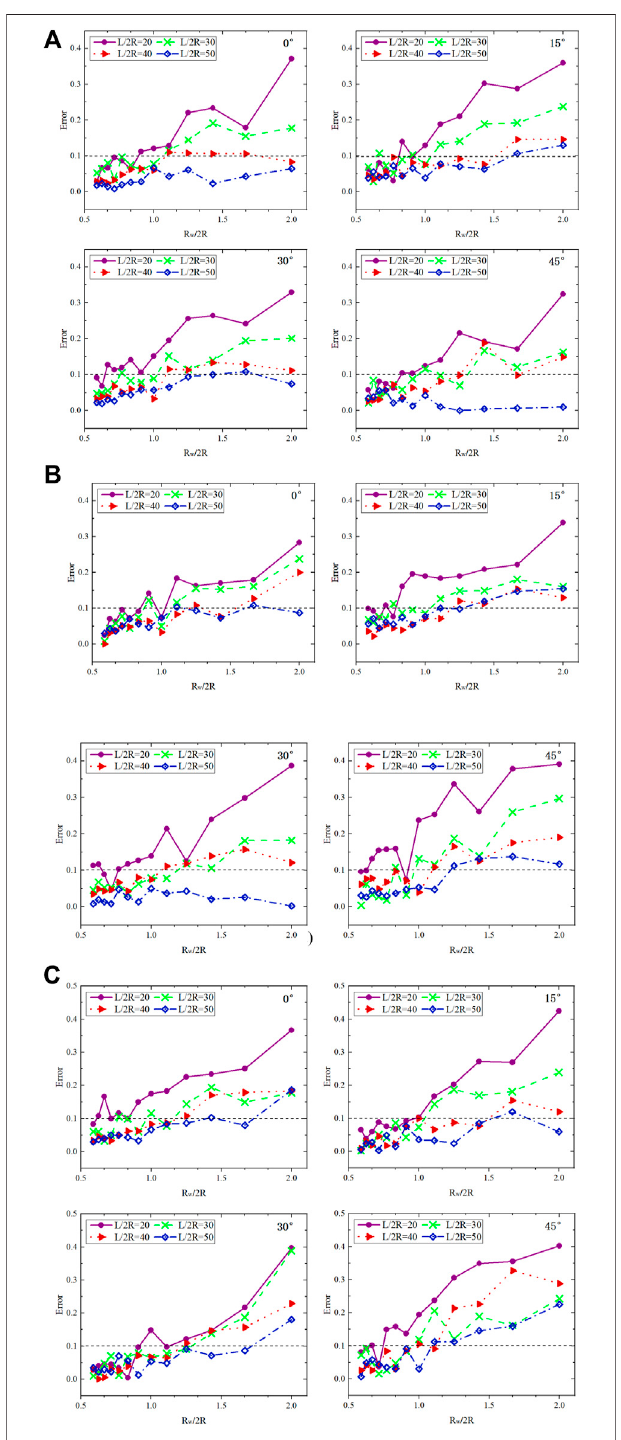
FIGURE 10 | Errors of estimated and realistic crack lengths vs. dimensionless parameter for these three double-crack DEM-DFN models as shown in Figure9 . (A) Distantdoublecracks. (B) Collinear doublecracks. (C) Stacked double cracks.